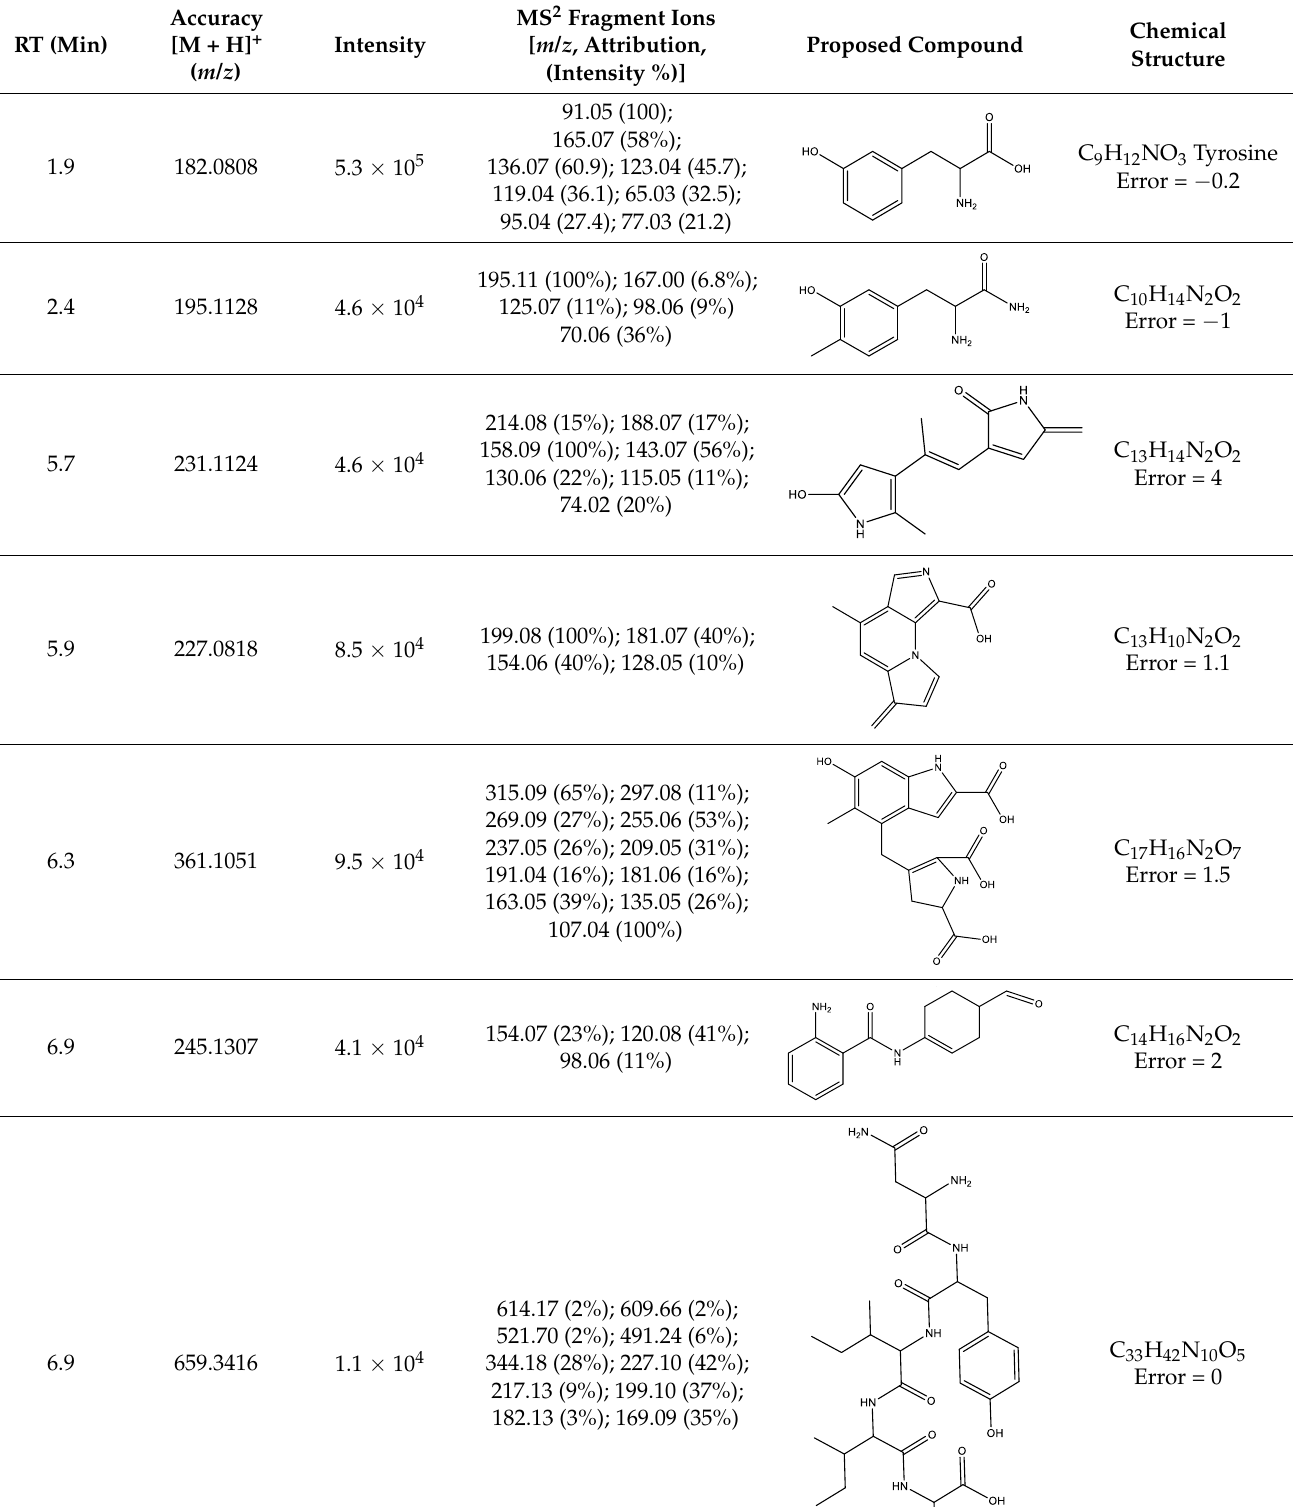
Figure 6. FTIR spectra in the range 4000–400 cm −1 . ( a ) Pseudomonas putida ESACB 191 melanin. ( b ) Sepia officinalis melanin. Table 1. Characterization of compounds present in Pseudomonas putida ESACB 191 melanin by UHPLC (+) HRMS/MS.